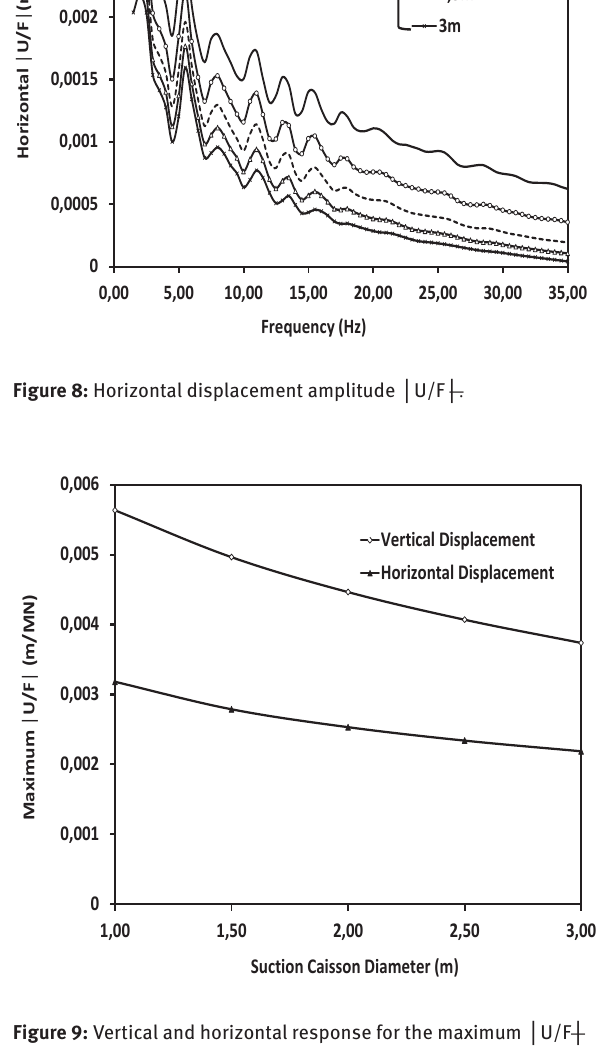
Figure 9: Vertical and horizontal response for the maximum │ U/F │ ̶ Figure 9 Vertical and horizontal response for the maximum │U/F│̶ Influence of the suction caisson Influence of the suction caisson diameter A fundamental characteristic is presented in Figure 8: